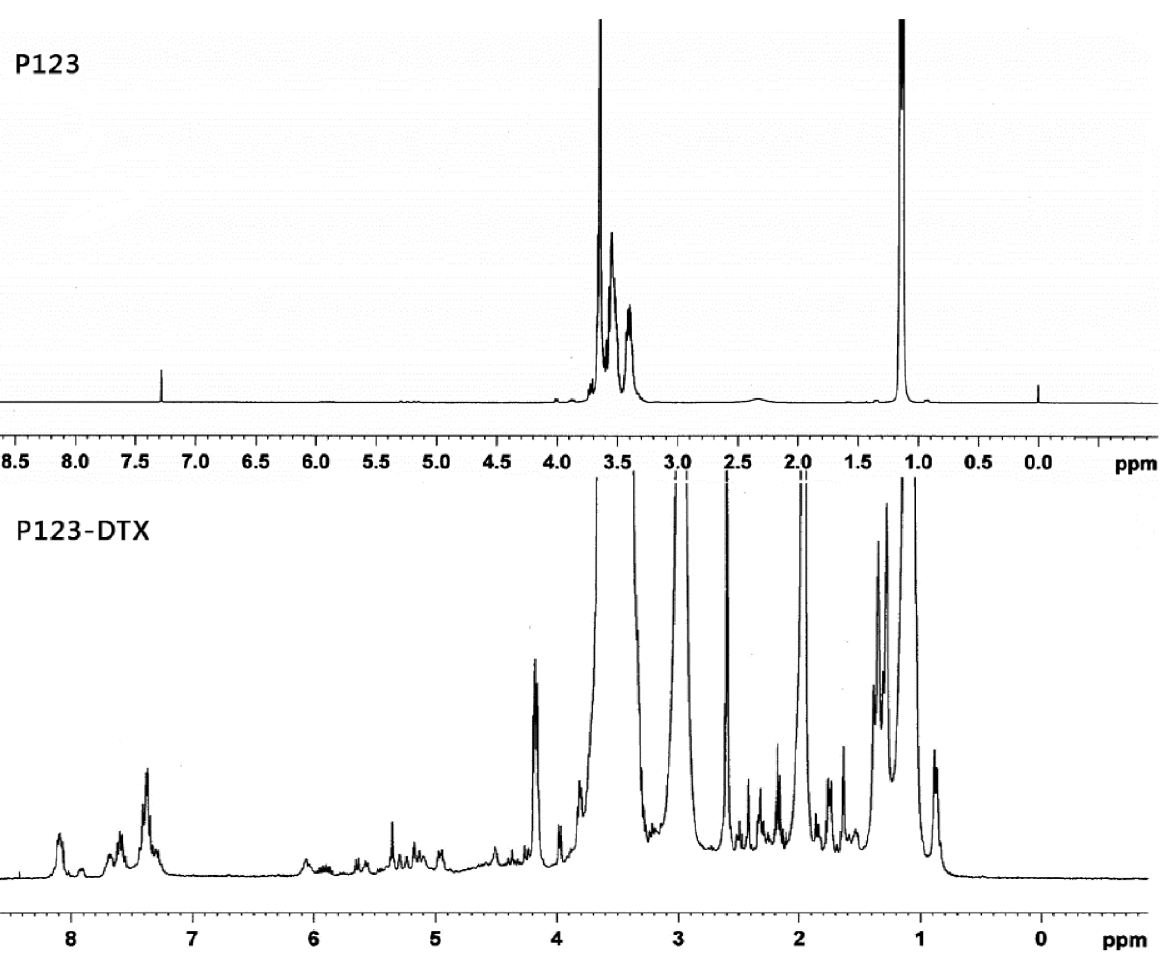
Figure 3. 1 H NMR spectrum of Pluronic P123 and P123-DTX conjugates in DMSO- d 6